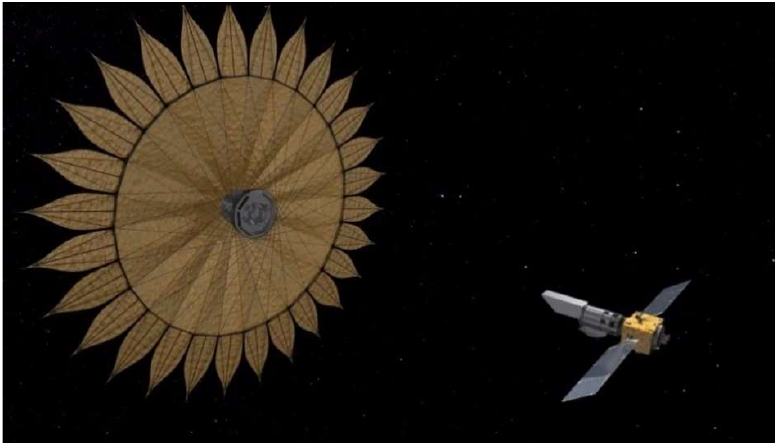
Figure 7. Artist concept of a starshade operating with a space telescope. The two spacecrafts are represented in a formation flying configuration. Credits: NASA/JPL-Caltech.